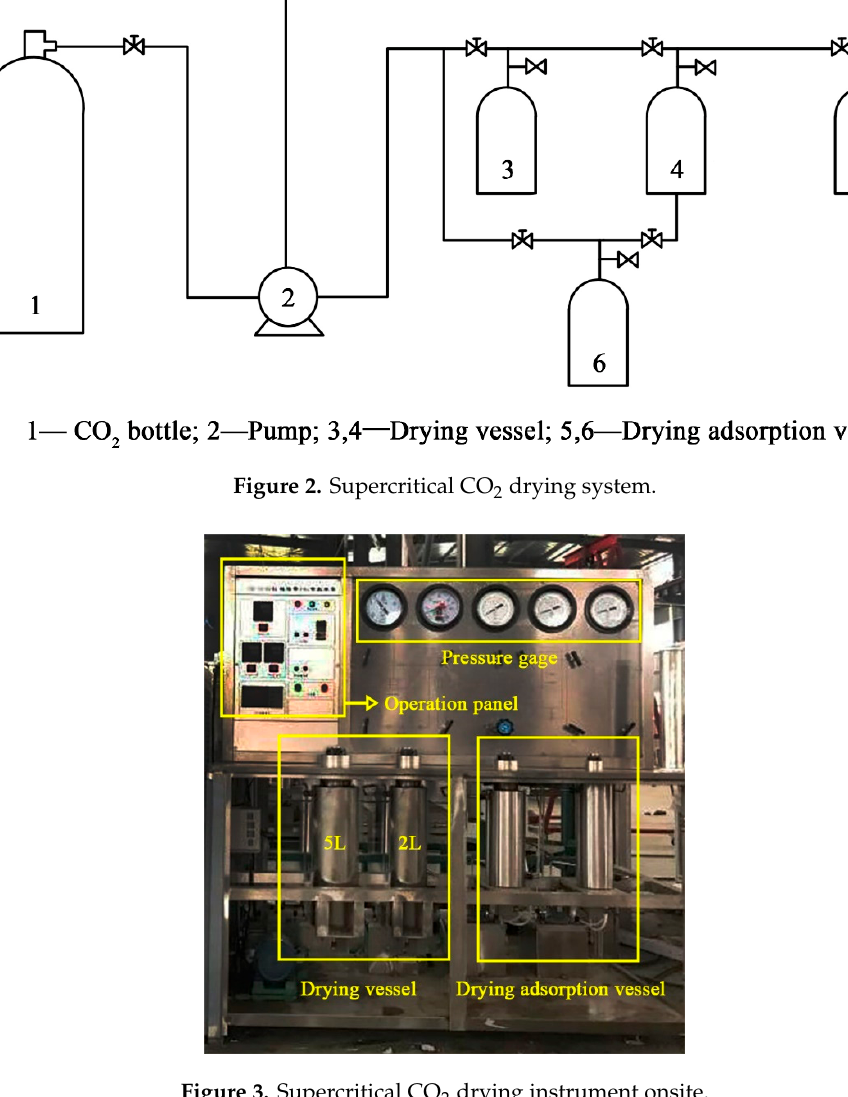
Figure 3. Supercritical CO 2 drying instrument onsite. Table 1. Parameters of supercritical CO 2 drying.